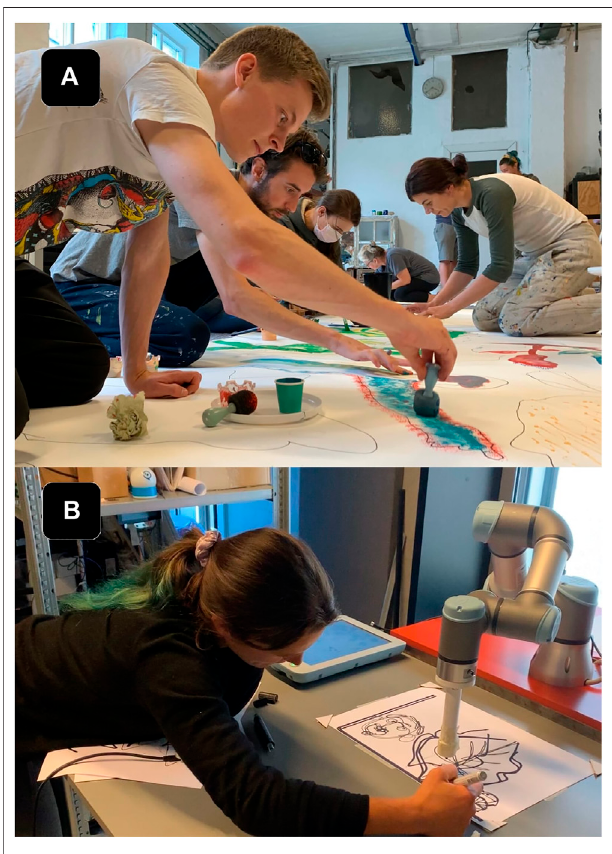
FIGURE 5 | (A) The research team engaged in several workshops at the artists ’ studio, exploring various painting tools and techniques with different instruments(sponges,stencils,inkpens,pipettes,etc.). (B) Artist(Rizzo)atthe HRI lab, testing an initial drawing collaboration using EMCAR with the UR3. EMCAR allows the artist to draw simultaneously on a shared canvas in real time, as in the artist ’ s studio. The system was an improvement over the pre-programmed drawings of the previous version of the software.